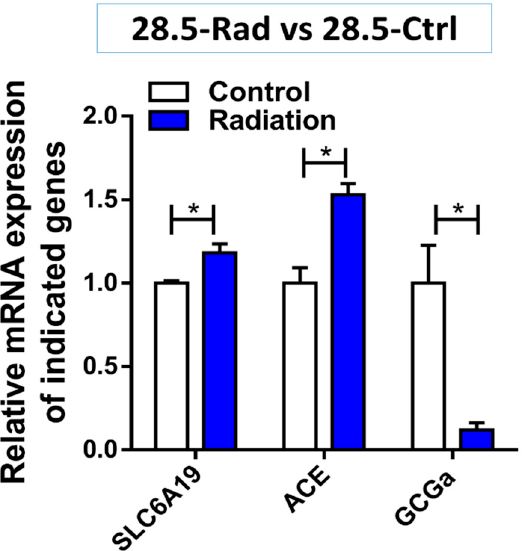
Figure 7. Gene expression in the radiation (28.5-Ctrl) group compared with control (28.5-Ctrl). The figure shows the increase in expression of SLC6A19 transporter ( p = 0.041) and the angiotensin system gene ACE ( p = 0.022) while GCGa involved in increasing blood sugar levels is downregulated ( p = 0.032) compared to the control. * p < 0.05.